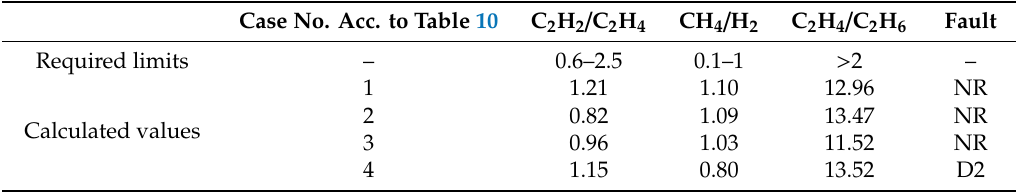
Table 11. The values of characteristic ratios required to determine the discharge of high energy as per the IEC 60599 Standard and the values calculated on the basis of measurement